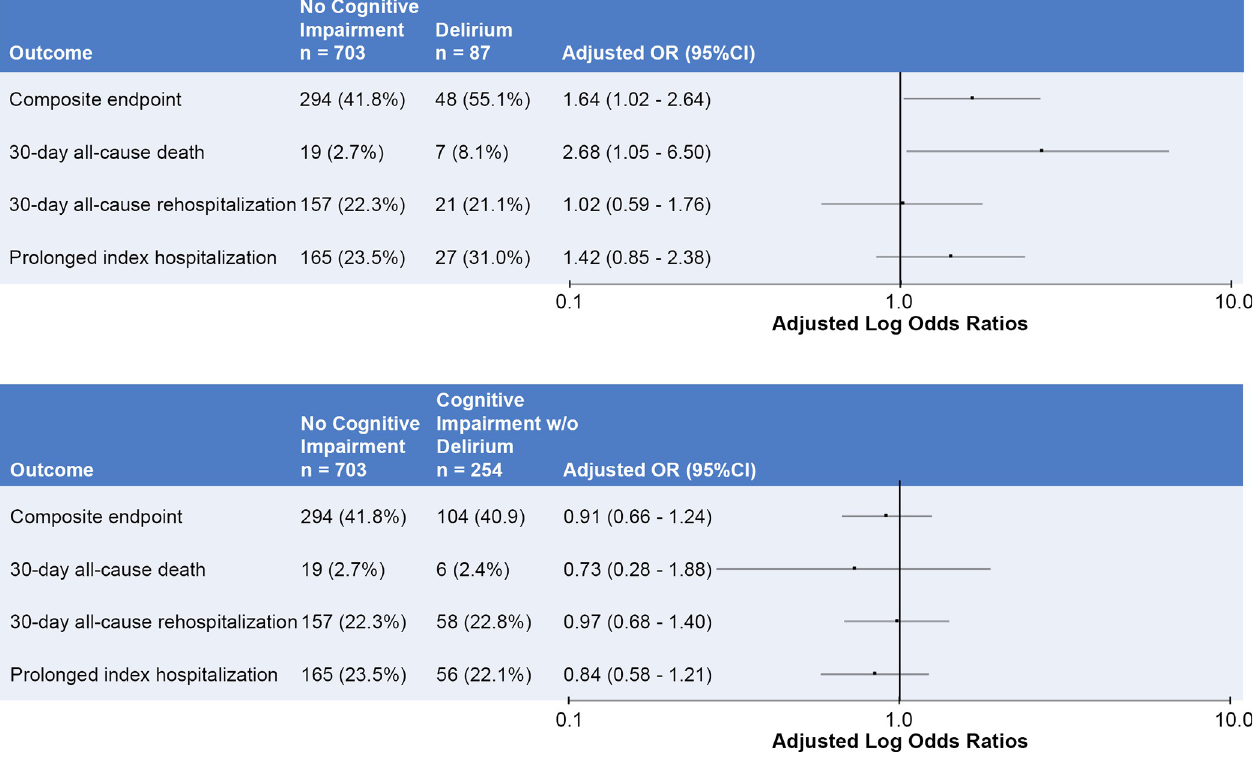
Fig 3. Adjusted odds ratios for delirium and cognitive impairment without delirium on the primary and secondary outcomes. The top panel represents delirium and the bottom panel represents cognitive impairment without delirium. OR, odds ratios; 95%CI, 95% confidence intervals.